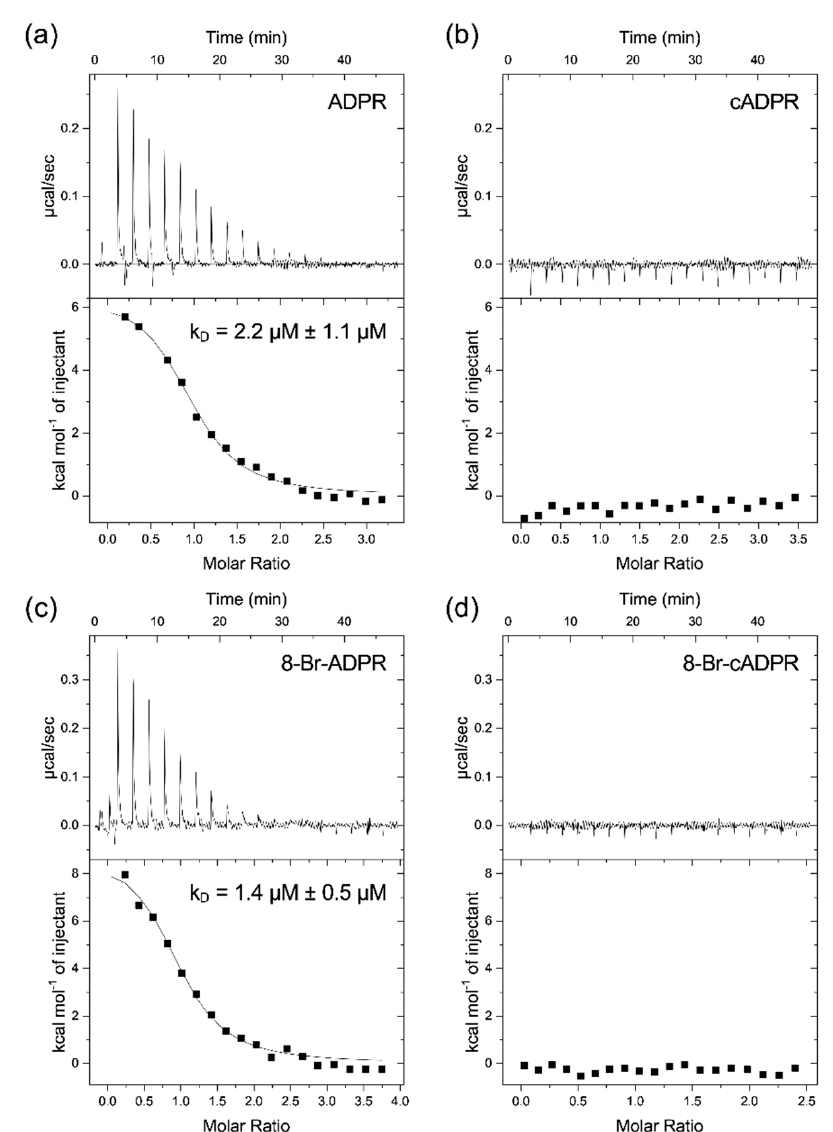
Figure 4. Binding of ADPR, cADPR, 8-Br-ADPR, and 8-Br-cADPR to the isolated MHR1/2 domain from drTRPM2. The isolated MHR1/2 domain from drTRPM2 was expressed in E. coli and purified by affinity and size exclusion chromatography and used to determine the binding affinity by isothermal titration calorimetry. The figure shows representative raw data and integrated peaks from 3 experiments per condition ( a ) ADPR, ( b ) cADPR, ( c ) 8-Br-ADPR, and ( d ) 8-Br-cADPR. The K D value is expressed as mean ± SEM ( n = 3). Raw data from individual experiments can be found in Supplementary Material Figure S2.